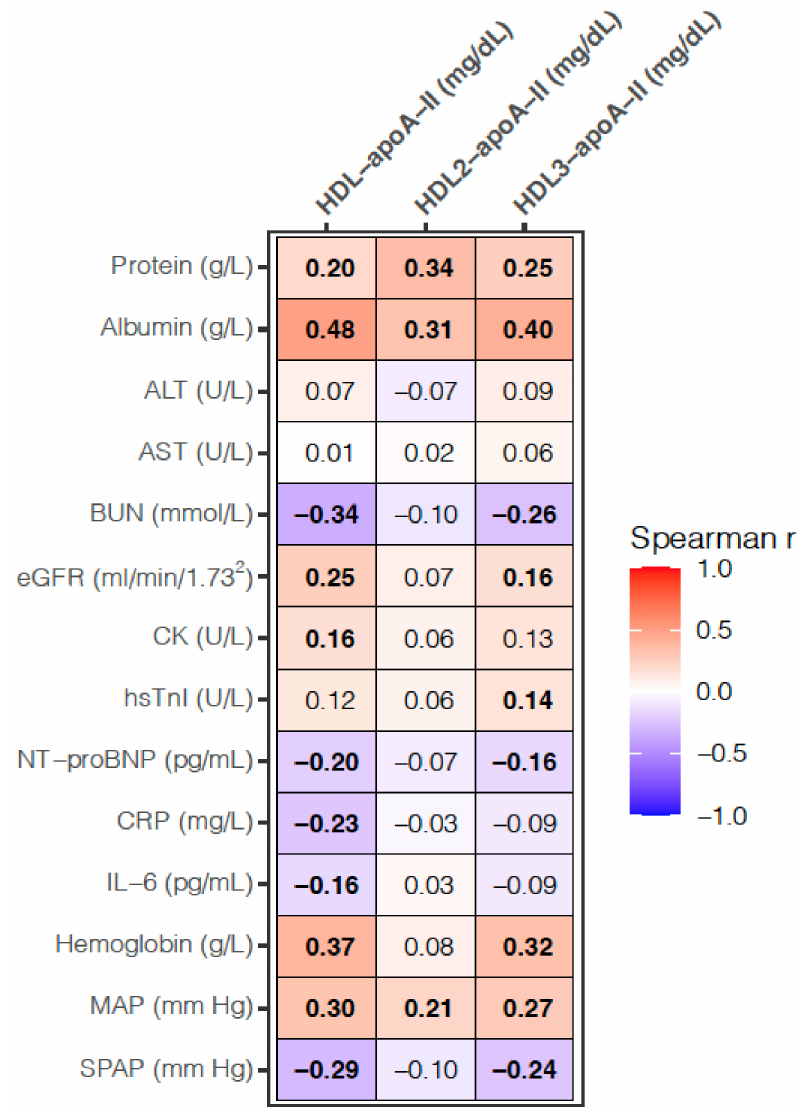
Figure 3. Heatmap for correlation analyses between the HDL and laboratory, as well as clinical parameters. Values presented are the Spearman correlation coefficient. p -values < 0.017 are considered significant after a Bonferroni correction for multiple testing and significant correlations are depicted in bold. SPAP was measured in 259 patients; otherwise, the analyses are based on 314 samples. BUN, blood urea nitrogen; CK, creatine kinase; CRP, C-reactive protein; eGFR, estimated glomerular filtration rate; hsTnI, high-sensitivity troponin I; MAP, mean arterial pressure; NT-proBNP, N-terminal pro-brain natriuretic peptide; SPAP, systolic pulmonary artery